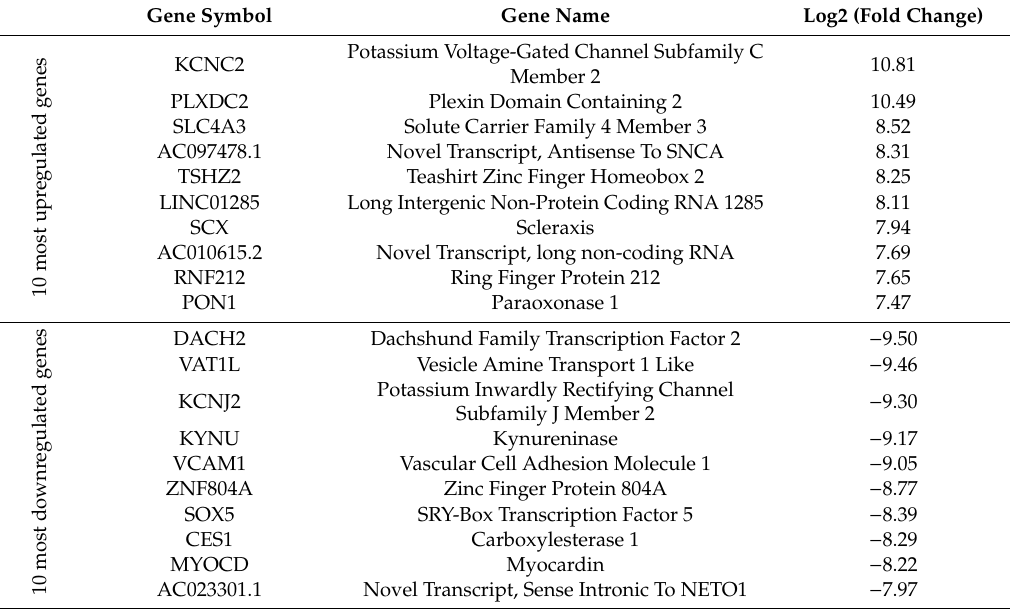
Table 1. The 10 most up- and downregulated genes in SCP1 GFP/SCX vs. SCP1 GFP cell pellets. Gene Symbol Gene Name Log2 (Fold